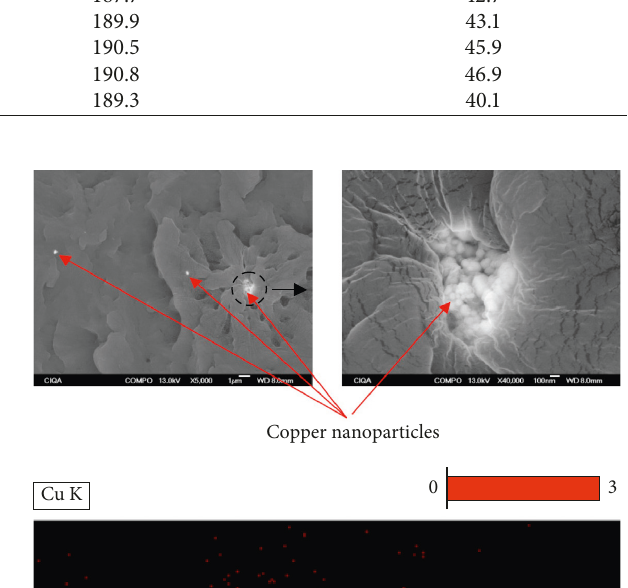
Table 1: Thermal properties of nylon 6 and its nanocomposites with copper nanoparticles. Nylon 6/nano-Cu Melting temperature, T m ( ° C) Crystallization temperature, T c ( ° C)